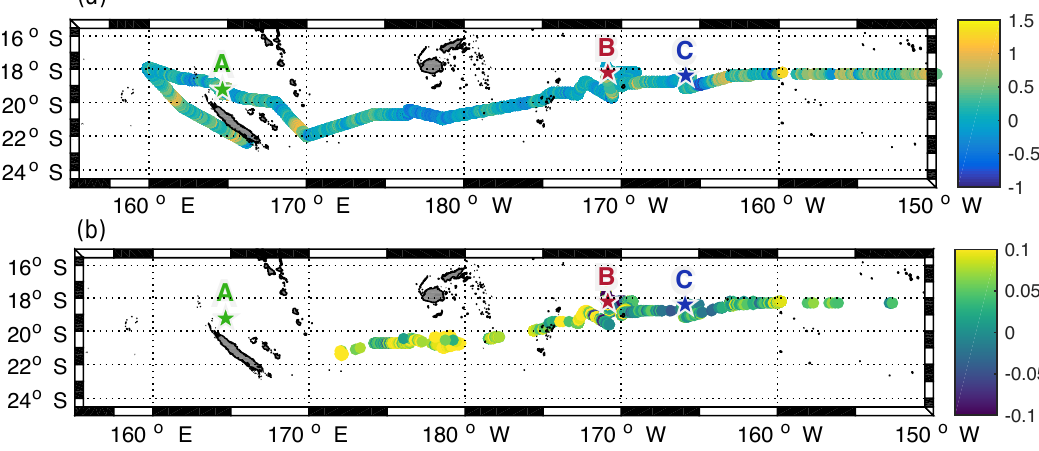
Figure A4. (a) Difference between in situ surface temperature from TSG and satellite-derived sea surface temperature from CLS ( ◦ C). (b) Difference between in situ surface chlorophyll concentration from the underway survey and satellite-derived sea surface chlorophyll concentration from CLS (mgm − 3